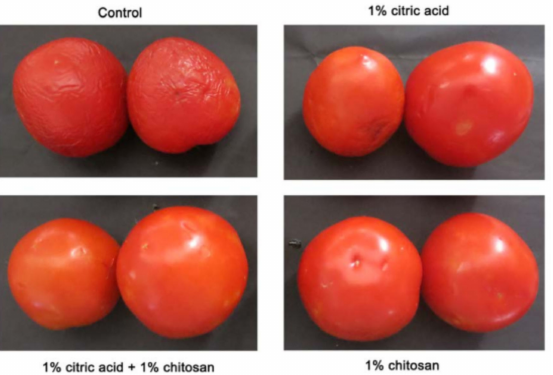
Figure 10. Conditions of tomato samples coated with chitosan and citric acid after 15 days at 28 ◦ C